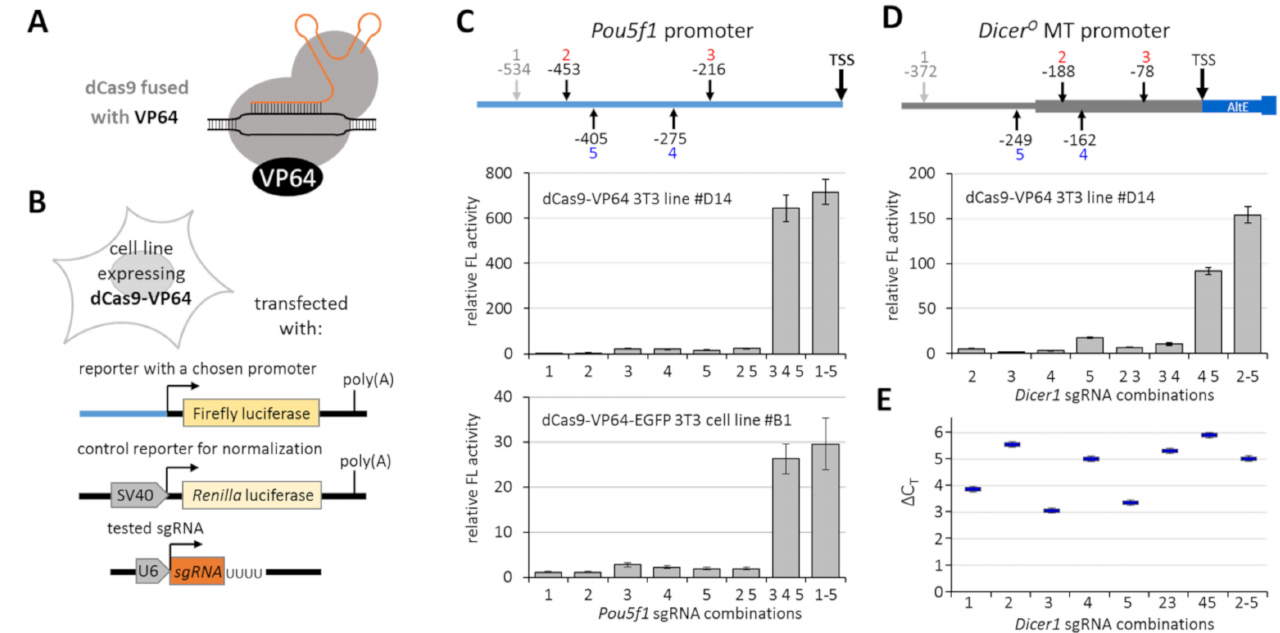
Figure 2. Transcriptional activation using a basic dCas9-VP64 system. ( A ) Schematic depiction of the basic dCas9-VP64 system version 1 composted of dCas9 fused with VP64 and a sgRNA. ( B ) Schematic depiction of the testing strategy built on NIH 3T3 cell lines stably expressing dCas9-VP64 fusions and transfected with plasmids expressing sgRNAs, a firefly reporter driven by a tested promoter, and a Renilla luciferase reporter as a control for normalization of transcriptional activation of the tested promoter. ( C ) Transcriptional activation of Pou5f1 promoter-reporter. The scheme depicts positions of sgRNAs relative to the Pou5f1 transcription start. sgRNA 1 was outside of the promoter region cloned into the firefly reporter, hence could serve as a negative control. The upper graph depicts results with dCas9-VP64, the lower one with dCas9-VP64-EGFP. Shown is the firefly luciferase activity normalized to Renilla luciferase; reporter activity in the absence of sgRNA was set to 1. ( D ) Transcriptional activation of the MTC promoter-reporter. As in ( C ), the scheme depicts the position of sgRNAs relative to the transcription start site, and sgRNA 1 was outside of the cloned promoter region. ( E ) Transcriptional activation of the endogenous MTC promoter in NIH 3T3 cells. The graph depicts relative expression calculated by the ∆∆ C T method; negligible basal expression detected in NIH 3T3 cells was set to 1. All error bars = standard